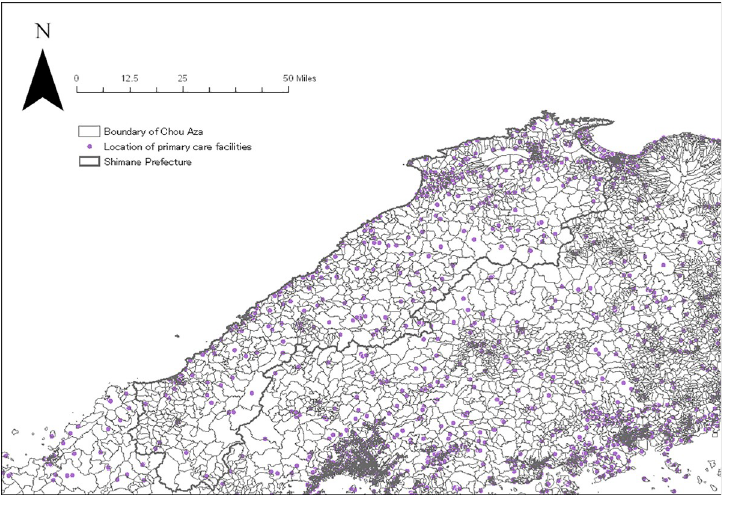
Fig 1. Location of primary care facilities in Shimane and four peripheral